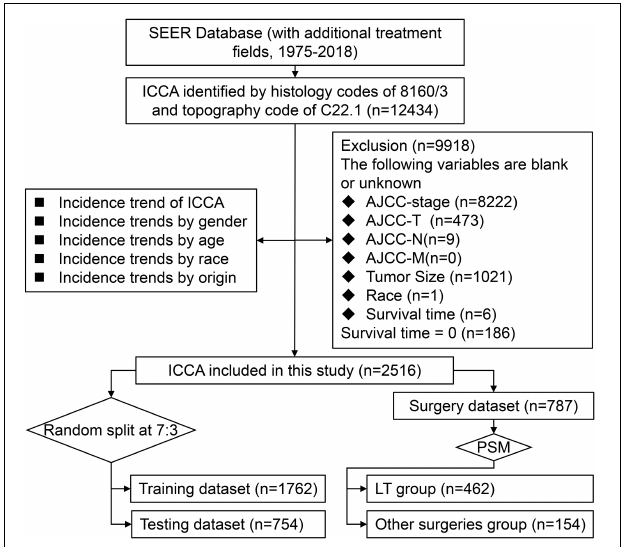
FIGURE 1 | Flowchart of screening patients with ICCA in the SEER